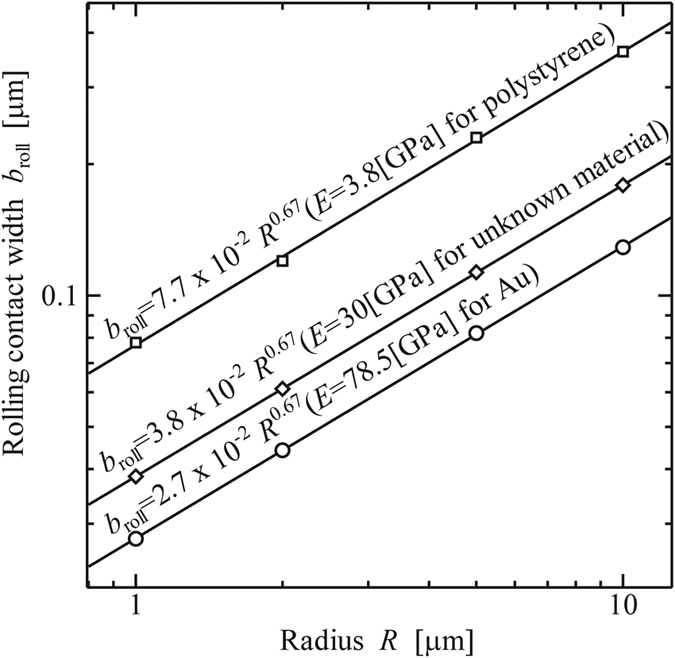
Width of contact area at the beginning of rolling, broll [μm].(Work of Adhesion: Δγ = 0.1 [N/m]).